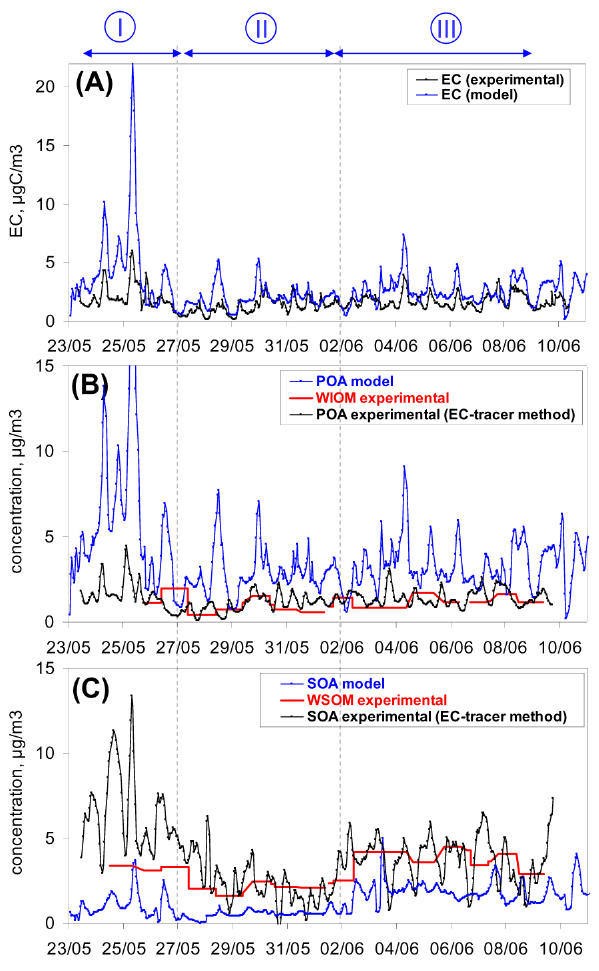
Fig. 12. Comparison of EC (A) , POA (B) , and SOA (C) determined from the CHIMERE model (in blue); the “EC-tracer” method (in black); and the “WSOC” method (in